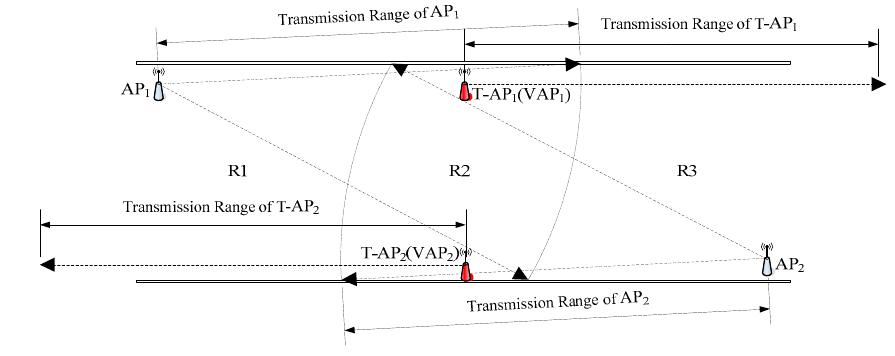
Figure 7. Diagram of VAP arrangement.